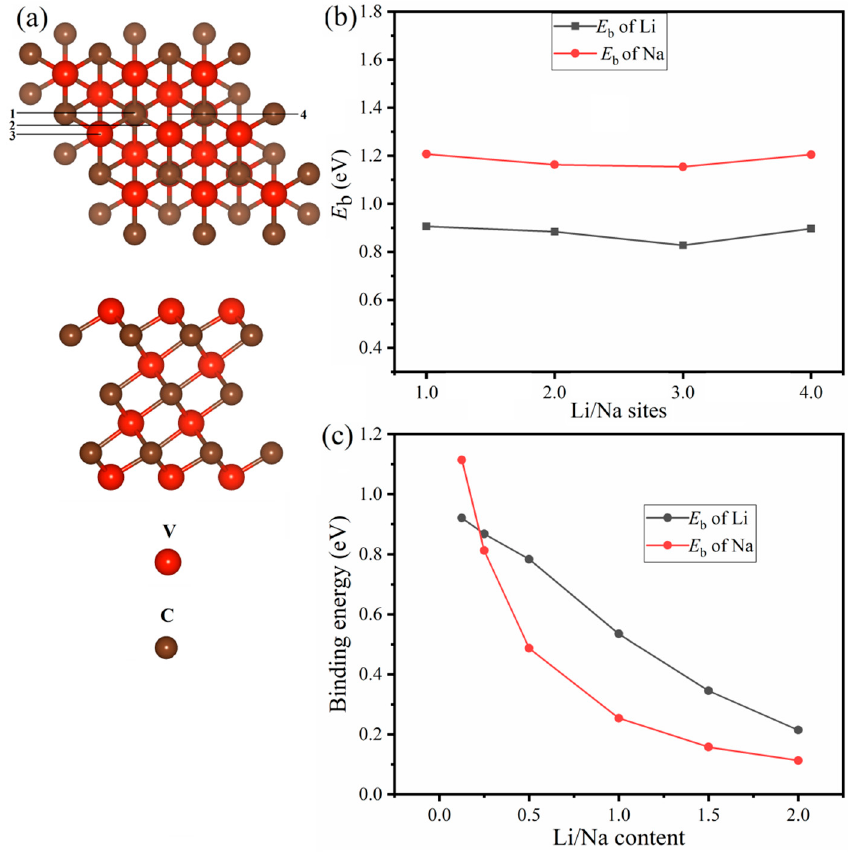
Figure 1. ( a ) Structural model of V 4 C 3 MX ene with top and side views and ( b ) stable Li/Na sites with their E b at x = 0.0625. ( c ) E b with increasing Li/Na content. The numbers 1,2,3, and 4 represent the adsorbed four sites site-1, site-2, site-3, and site-4, respectively.